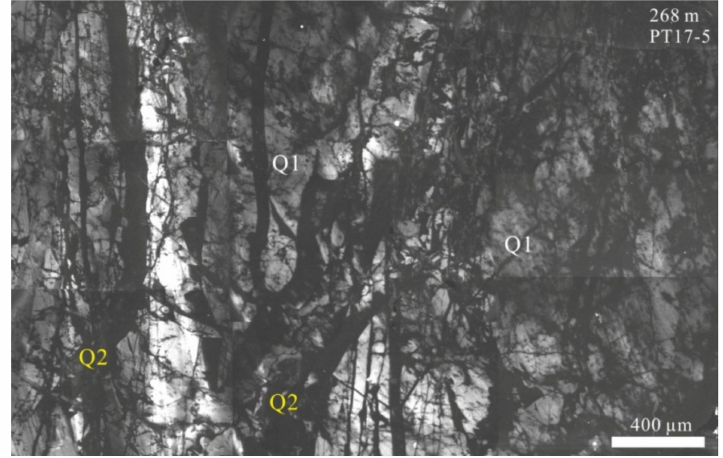
Figure 10. Composite SEM–CL panchromatic images of the sample PT17-5 at the 268 m level. The CL–bright quartz is crosscut by CL–dark quartz.